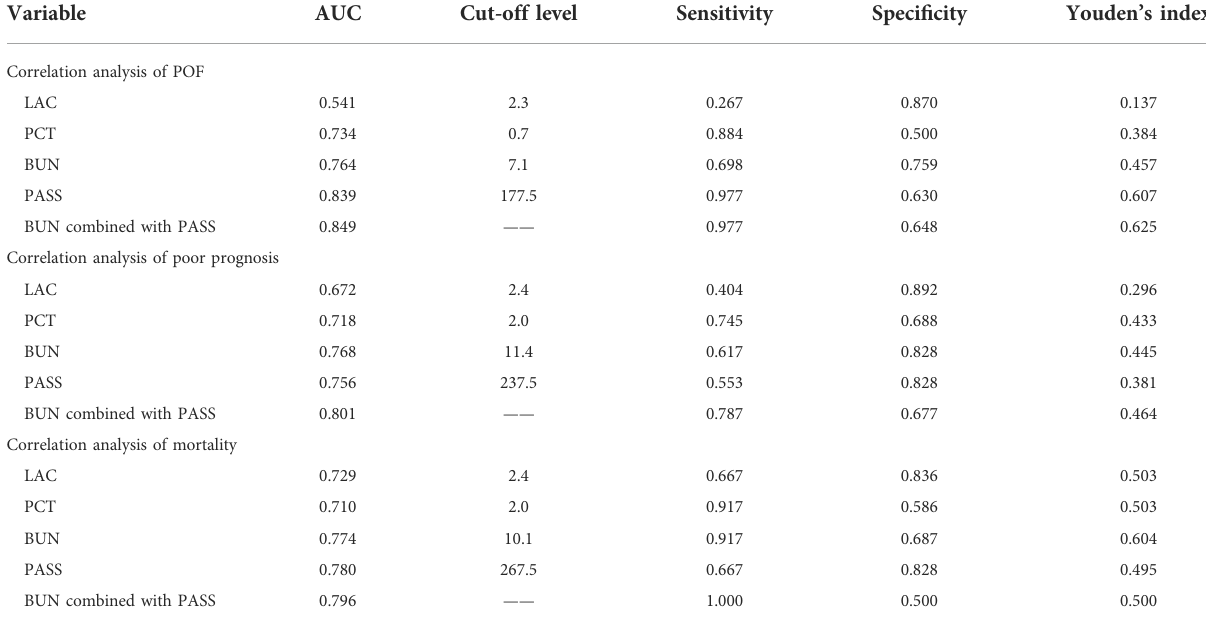
TABLE 4 ROC curve analysis of potential clinical predictors of AP